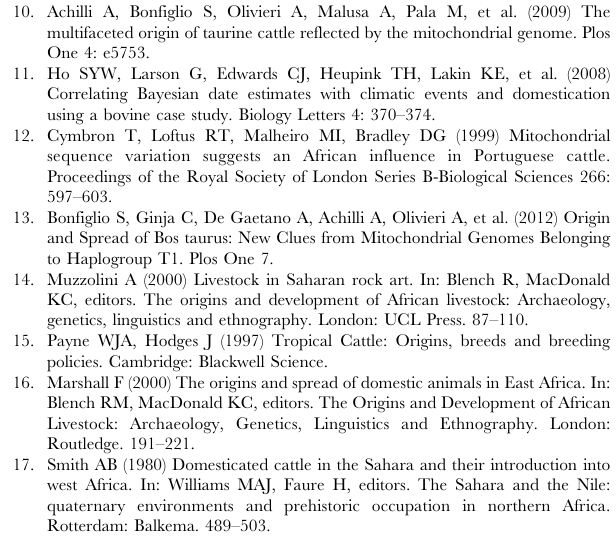
Figure S1 Demographic history of Nguni cattle. (A) Reconstructions using a relaxed molecular clock. Left: Constant size prior and Right: Bayesian Skyline Plot. (B) Reconstructions using a strict molecular clock. Left: Constant size prior and Right: Bayesian Skyline Plot. Figure S2 Model-based inference of population rela- tionships in African cattle using a linear with constant root population size model. (A) Posterior consensus tree. Blue beams indicate 95% HPD intervals of the respective split timing. Mean estimates are provided at the respective nodes. (B) Summary of posterior trees (blue) generated using DensiTree (part of the BEAST2 package). Green lines indicate female effective popula- tion size changes over time projected onto the tree. Mean estimates are provided. Italic numbers indicate Bayesian branch support. Figure S3 Model-based inference of population rela- tionships in African cattle using a constant population